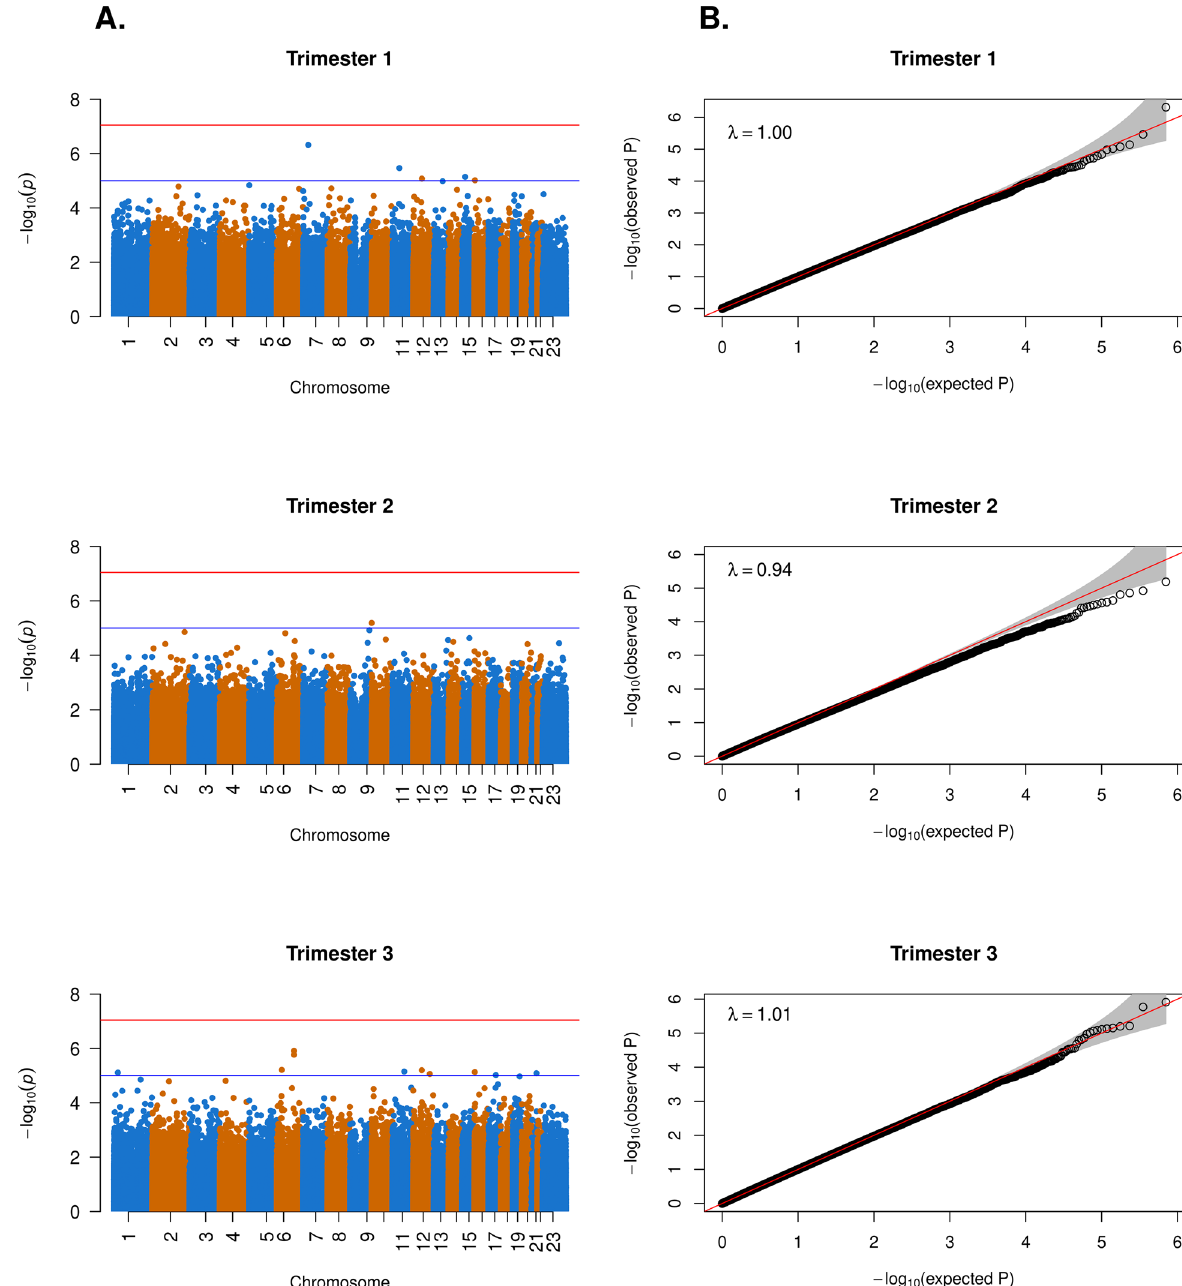
Fig. 1 Manhattan and QQ plots for trimesters 1, 2, and 3. A Manhattan plots displaying -log 10 ( p value) on y -axis and chromosome number on x -axis. The red line represents the threshold for genome-wide significance with a p value of 9 10 -8 ; the blue line represents the threshold for suggestive × significance with a p value of 1 10 -5 . B QQ plot with 95% confidence interval displaying observed -log 10 ( p value) on y -axis and expected -log 10 ( p × value) on x -axis; the red line represents where the points should fall under the null of no association if the statistical tests are well-calibrated and effects of population substructure and other batch effects are well-controlled